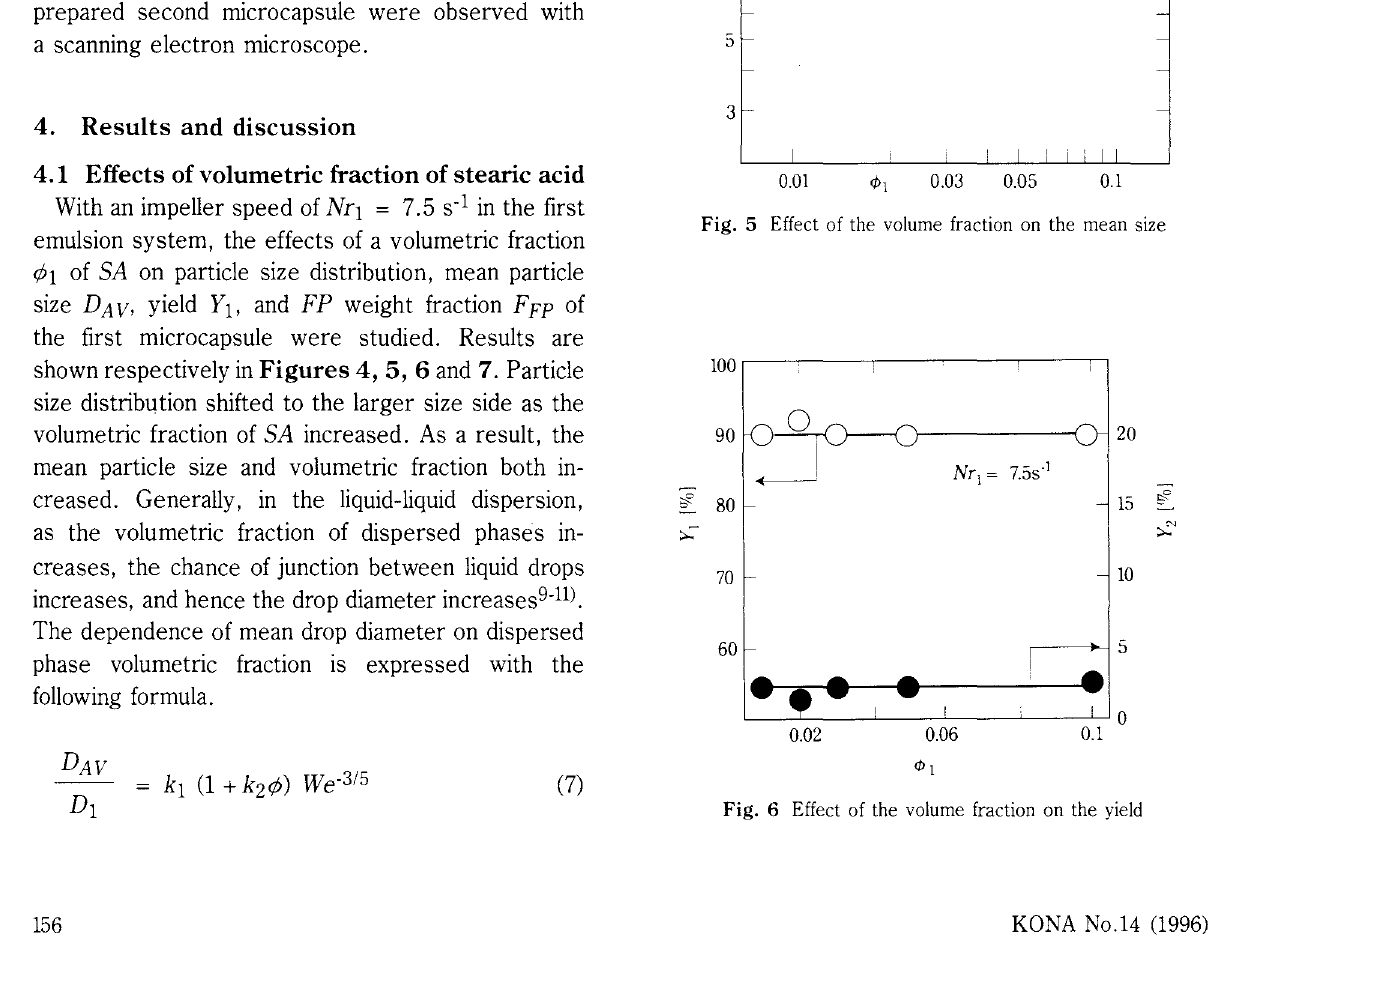
Fig. 6 Effect of the volume fraction on the